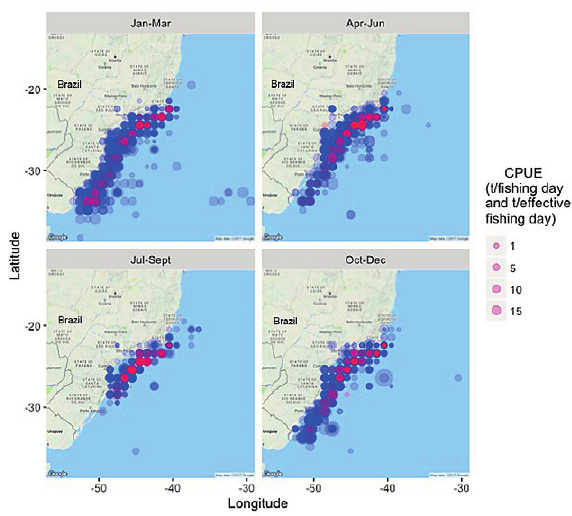
Fig. 10. – Quarterly maps of the total CPUE in the Maldives (units: in blue t/fishing day; in red t/trip).